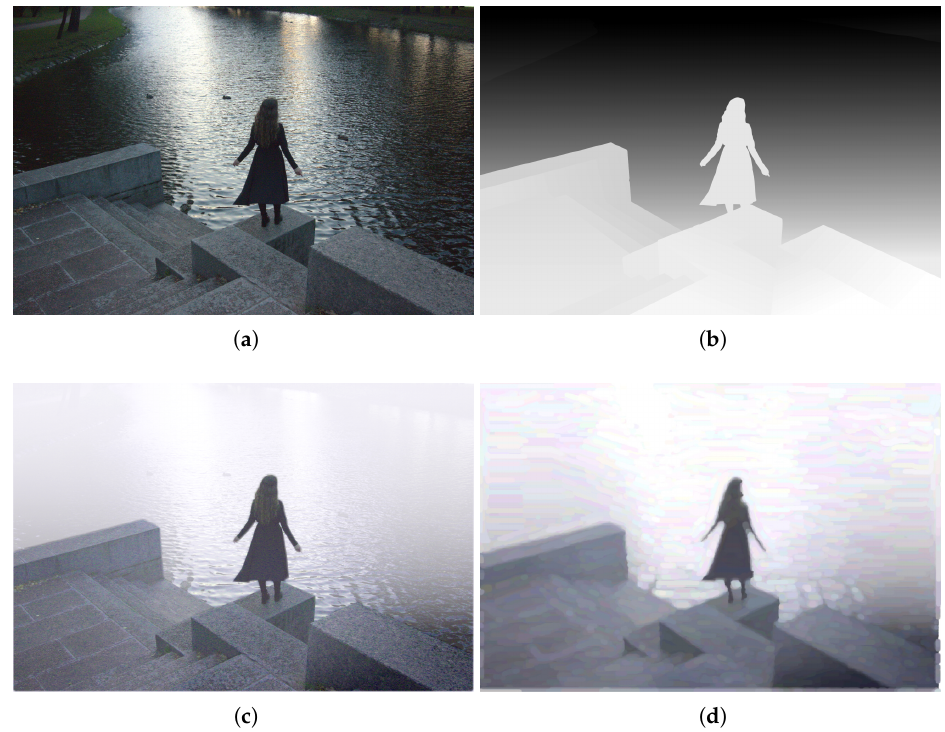
Figure 9. Aerial perspective enhancement of the source image ( a ) using the manually painted depth map ( b ) leads to a misty image ( c ), which is then rendered to obtain an etude-like composition ( d ) painted with a thick